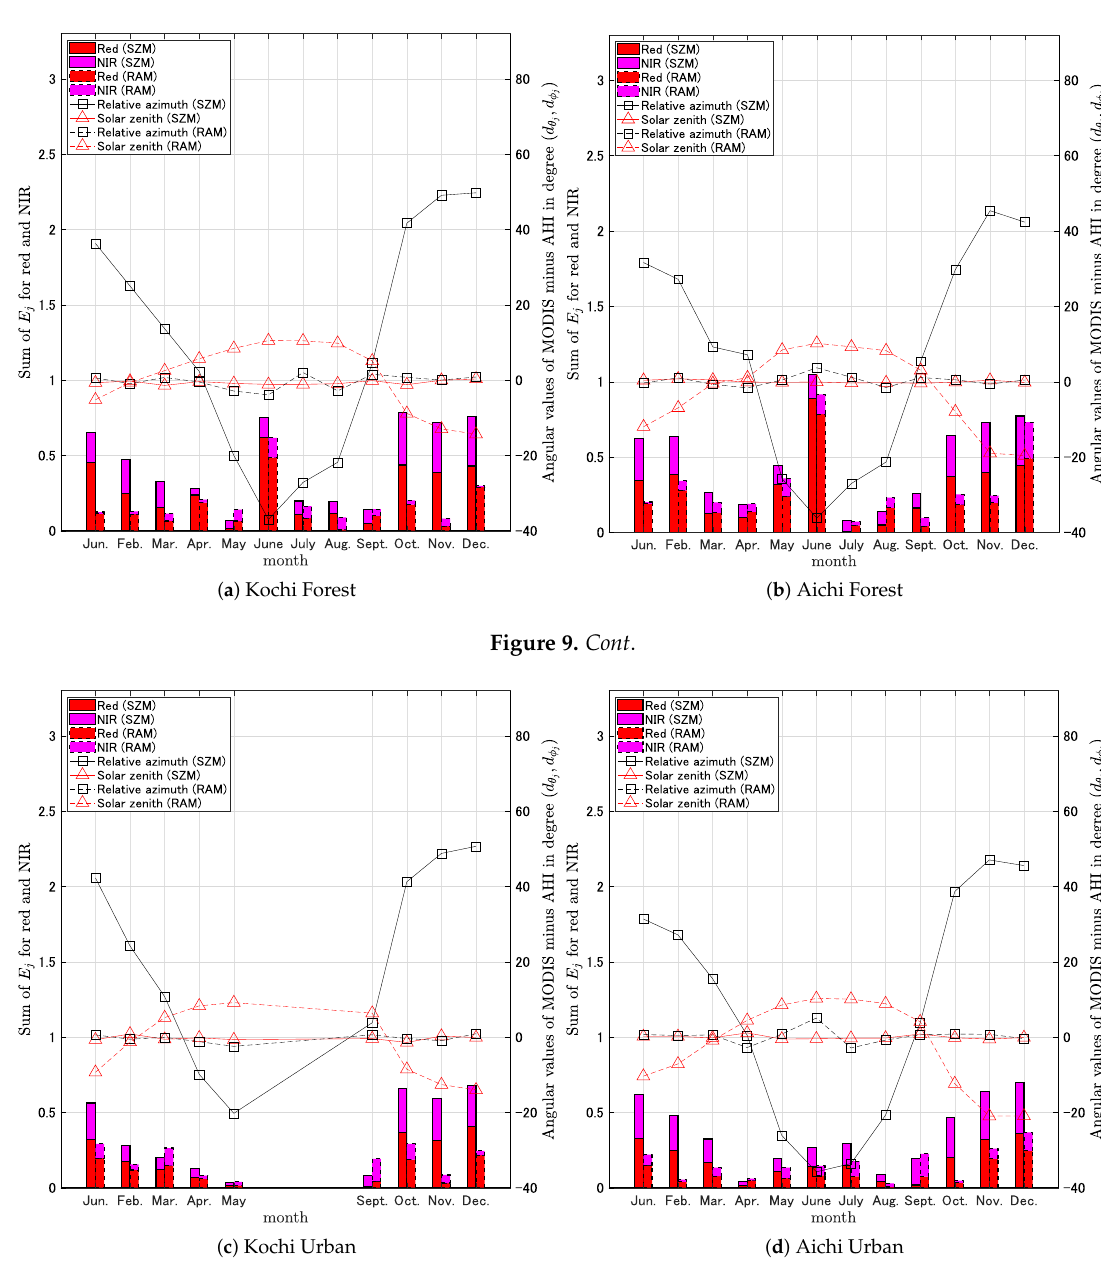
Figure 9. Same plot ( E j ) as shown in Figure 8, but only over the red and NIR bands: ( a ) Kochi Forest; ( b ) Aichi Forest; ( c ) Kochi Urban; and ( d ) Aichi